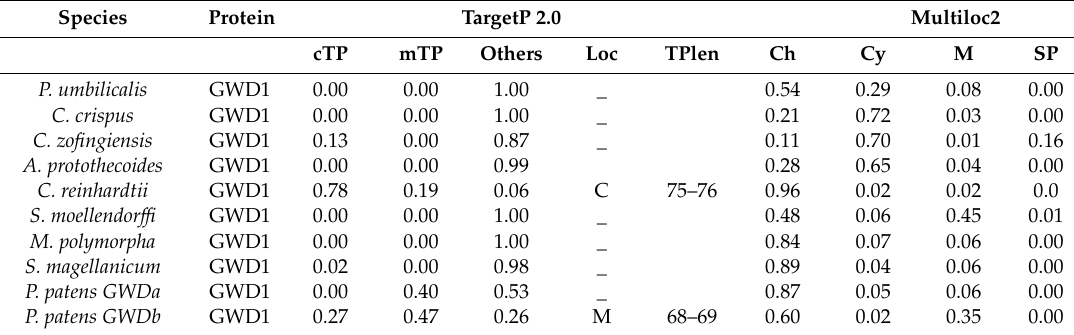
Table 2. Prediction of GWD localization